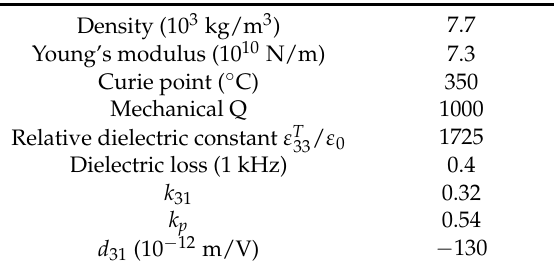
Table 1. Physical properties of